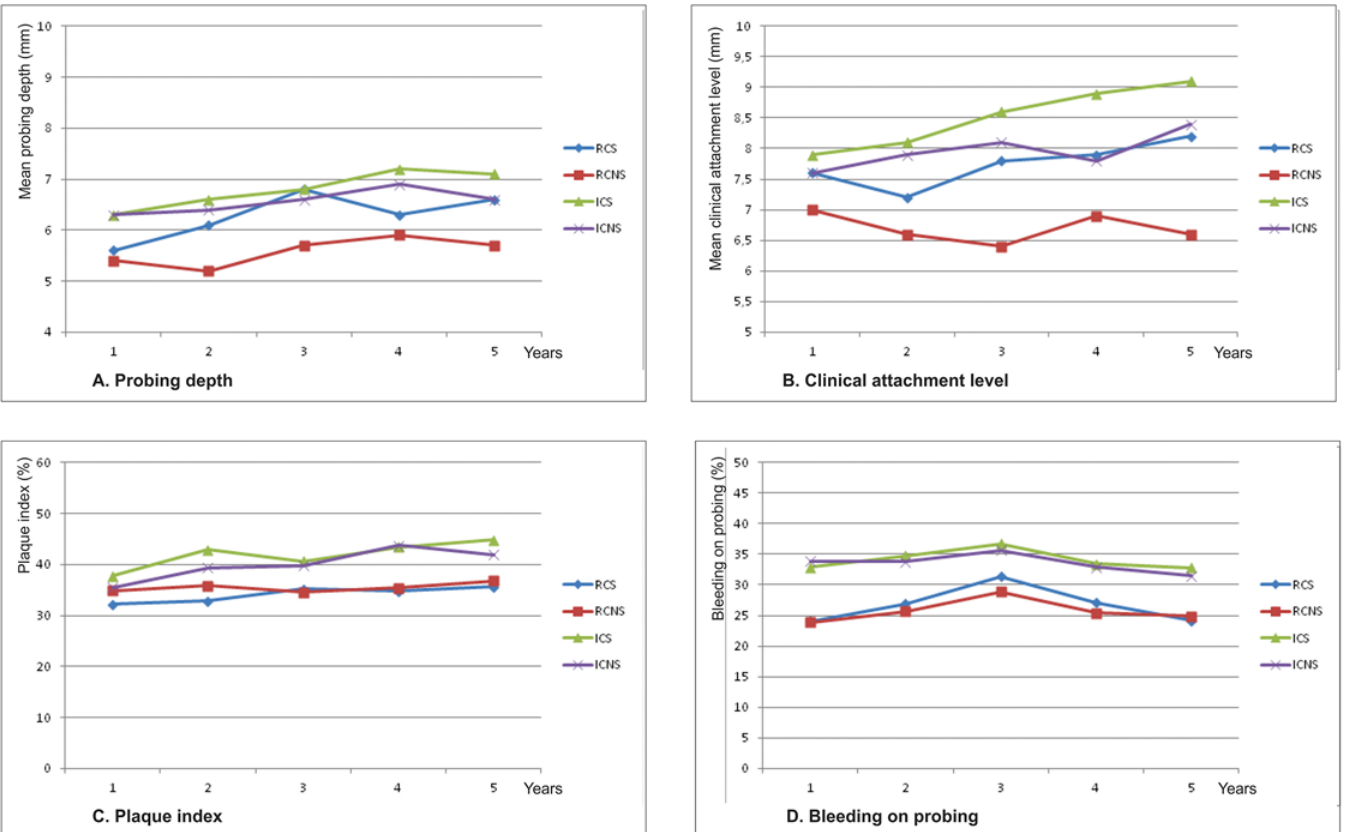
Fig 1. Changes in PD, CAL, PI, and BOP at 1-to-5 years (mean per individuals) by surgical or non-surgical procedures in RC and IC individuals with recurrence of periodontitis. Probing depth and Clinical attachment level (Fig 1a and Fig 1b): IC > RC;IC Surgical (ICS) > IC Non-Surgical (ICNS) = RC Surgical (RCS) > RC Non-Surgical (RCNS) * ; Plaque index (Fig 1c): IC > RC; ICS > ICNS and RCS = RCNS ** ; Bleeding on probing (Fig 1d): IC > RC; RCS = ICS and ICS = ICNS * ; * Statistically significant increase in PD, CAL, and BOP per years, using Welch test and Tamhane post hoc analysis (p < 0.05).